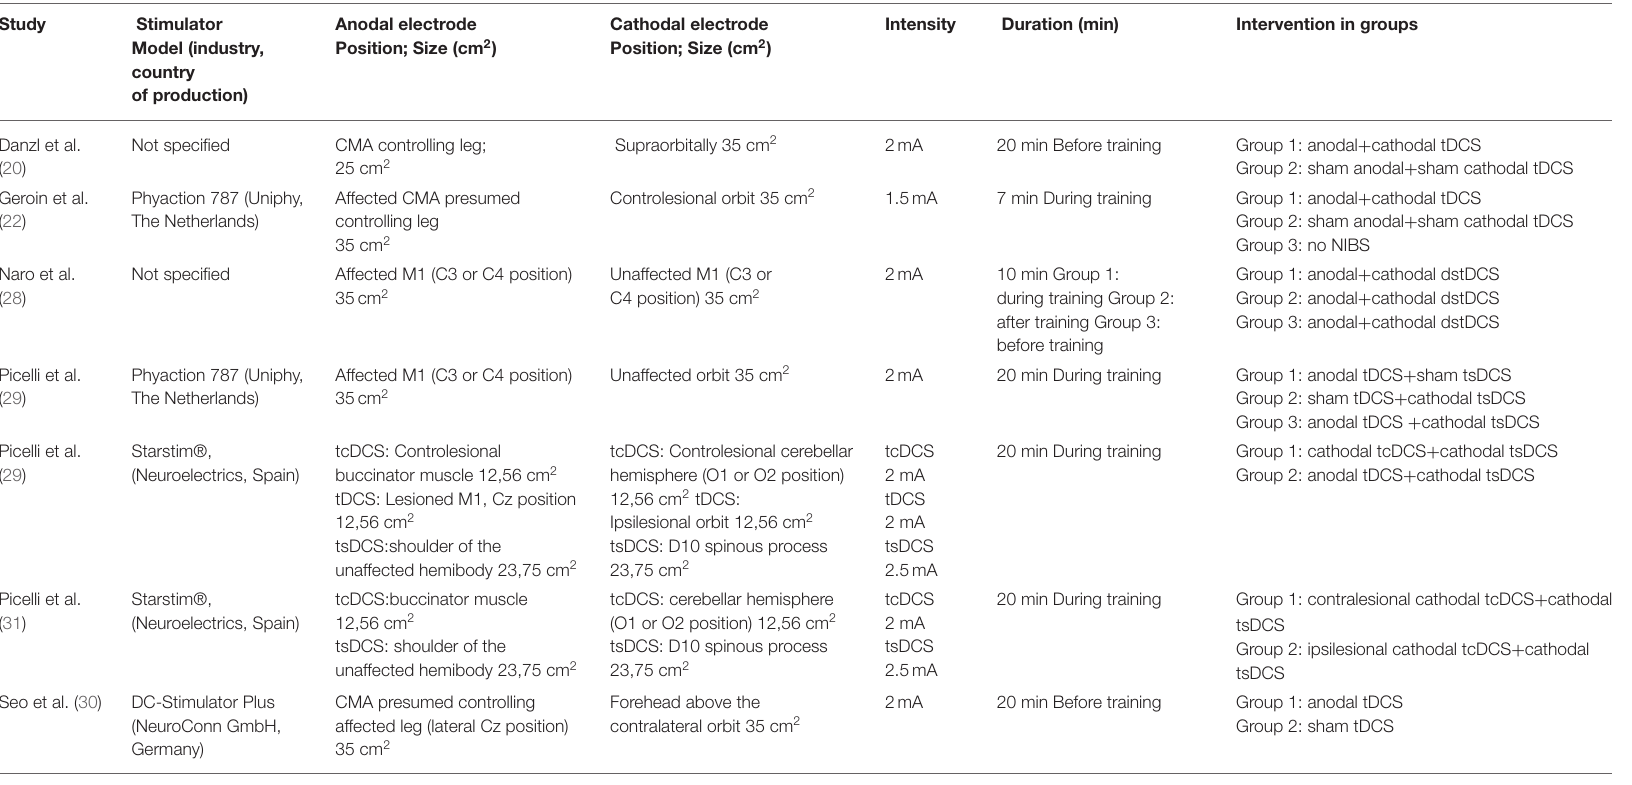
TABLE 4 | Characteristics of